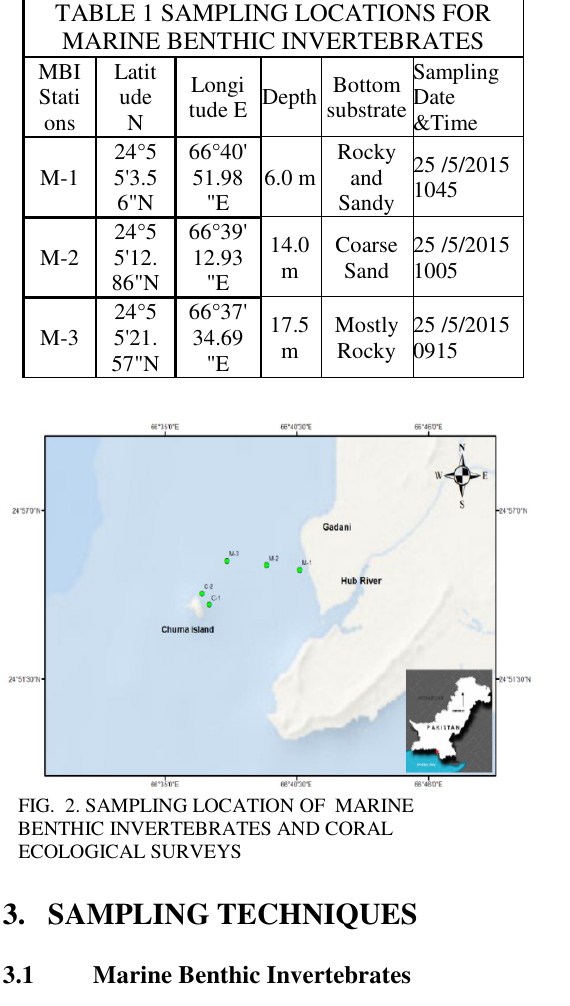
FIG. 2. SAMPLING LOCATION OF MARINE BENTHIC INVERTEBRATES AND CORAL ECOLOGICAL